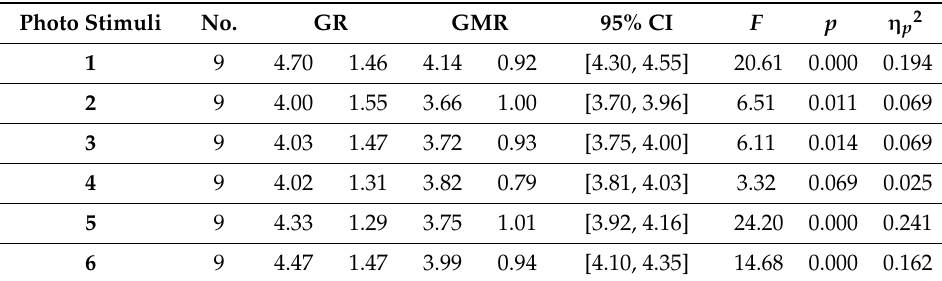
Table 8. Comparisons between GR and GMR from Study II ( n =